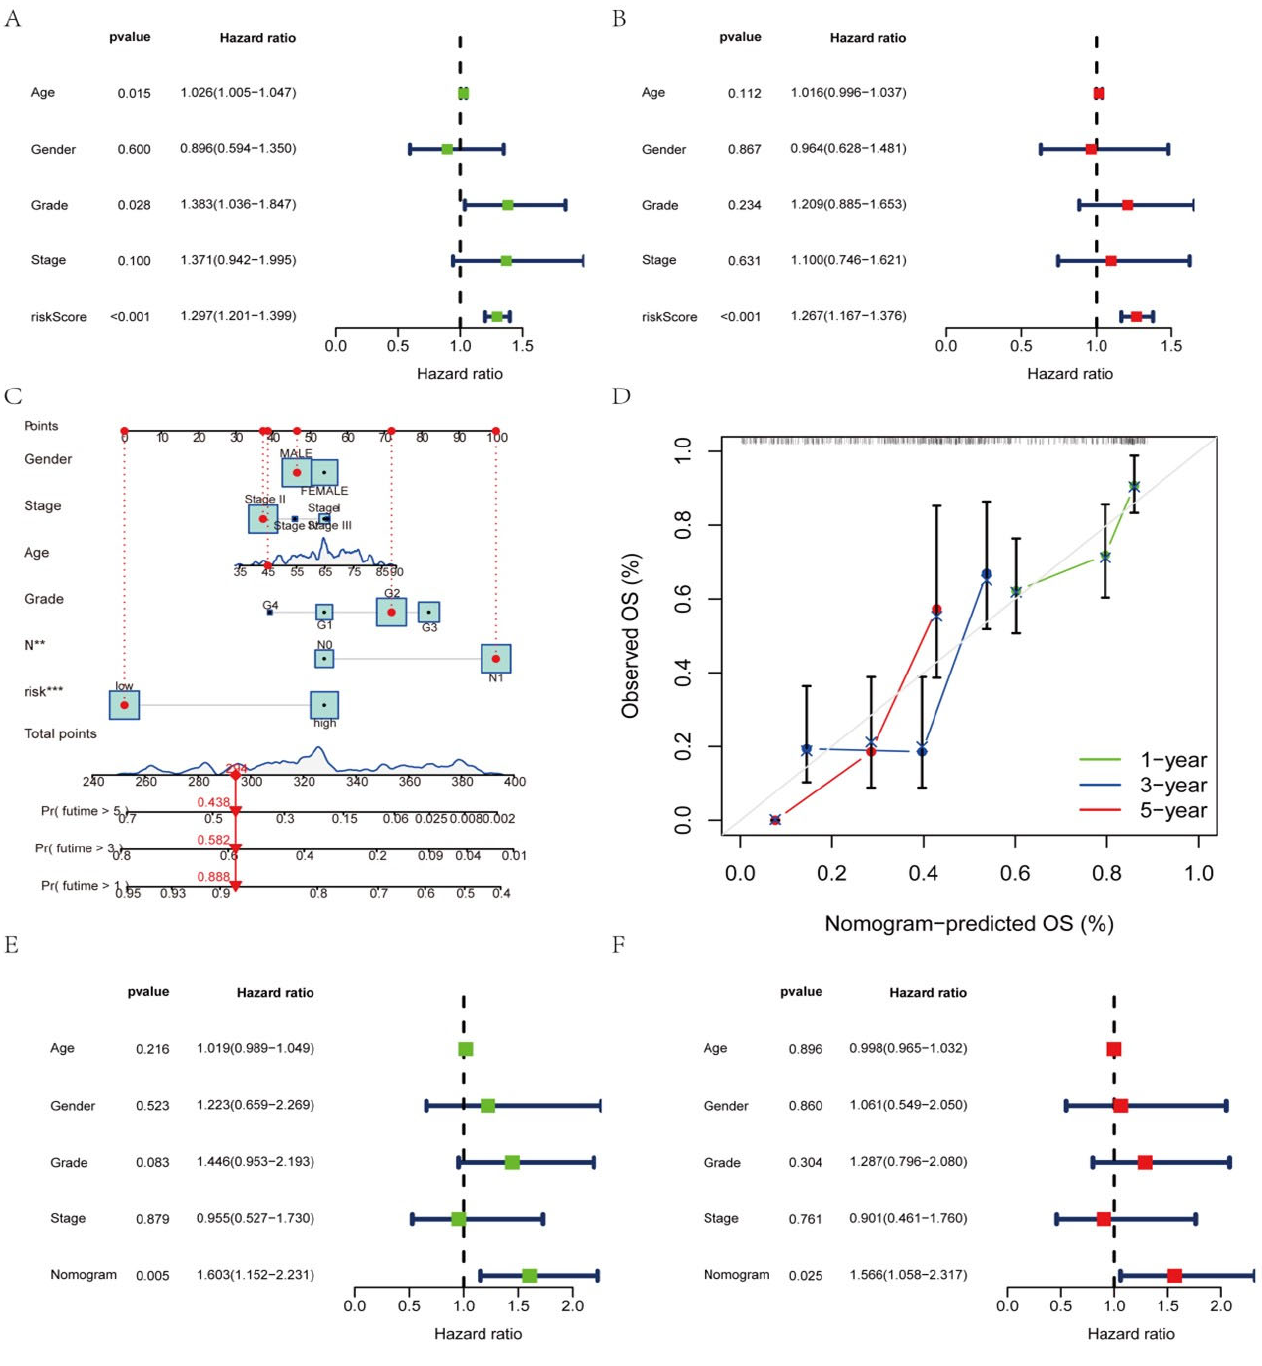
Figure 7. Establishment of the nomogram and evaluation of independent prognostic factors.(* p < 0.05; ** p < 0.01; *** p < 0.001) ( A , B ) Uni – COX and multi – COX regression analysis. ( C ) The nomo ‐ gram for estimating the OS of individuals with PAAD after one year, three years, and five years. ( D ) The calibration curve of the nomogram. ( E , F ) Uni – COX and multi – COX regression analysis with the age, gender, grade, stage, and nomogram.